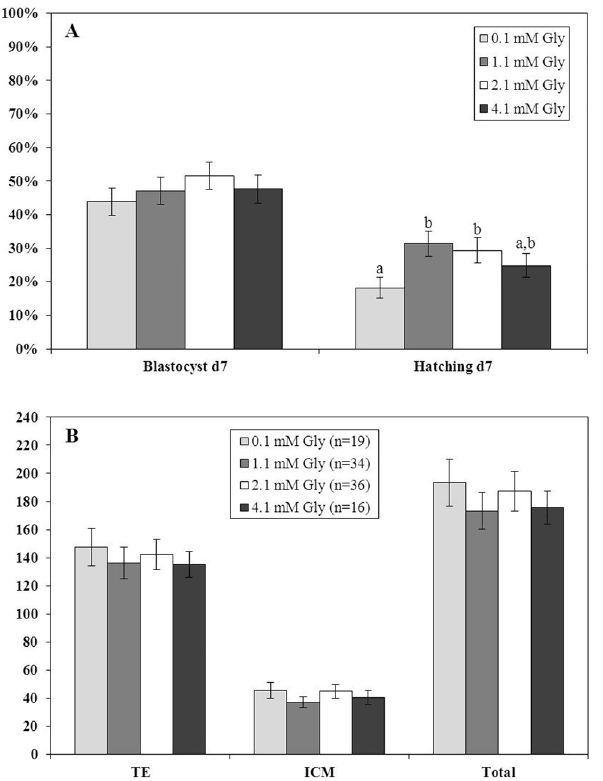
Fig 4. Embryonic development (per embryo > 4 cells on day 3, A) and blastocysts cell numbers (B) for embryos cultured with 0.1, 1.1, 2.1, or 4.1 mM Gly for the final 96 h of culture (8-cell to hatching). The number of cells in the trophectoderm (TE) and inner cell mass (ICM) and the total number of cells were determined in hatching or hatched blastocysts. a,b Different letters indicate a significant (P < 0.05) difference between treatments. If no superscripts are present, treatments were not different (P >